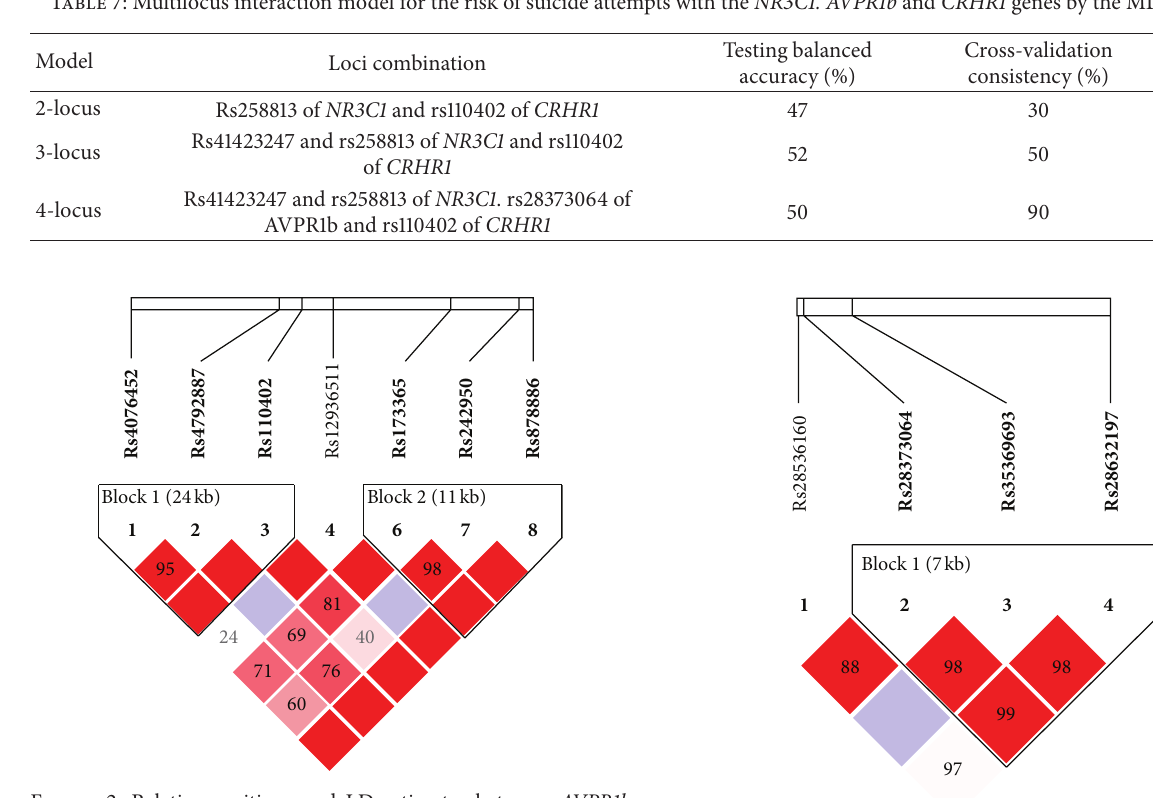
Figure 2: Relative positions and LD estimates between AVPR1b polymorphisms in the analyzed population. Coloured squares cor- respond to 𝐷 󸀠 values with numerical estimates given within the squares.